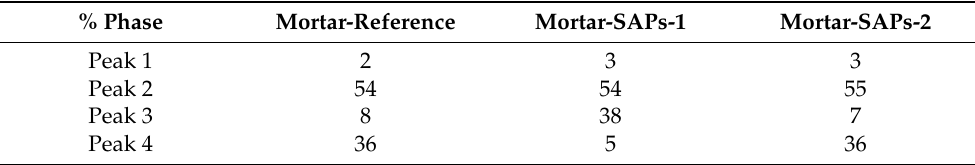
Table 4. Quantitative determination of the different cement phases identified in the mortars.